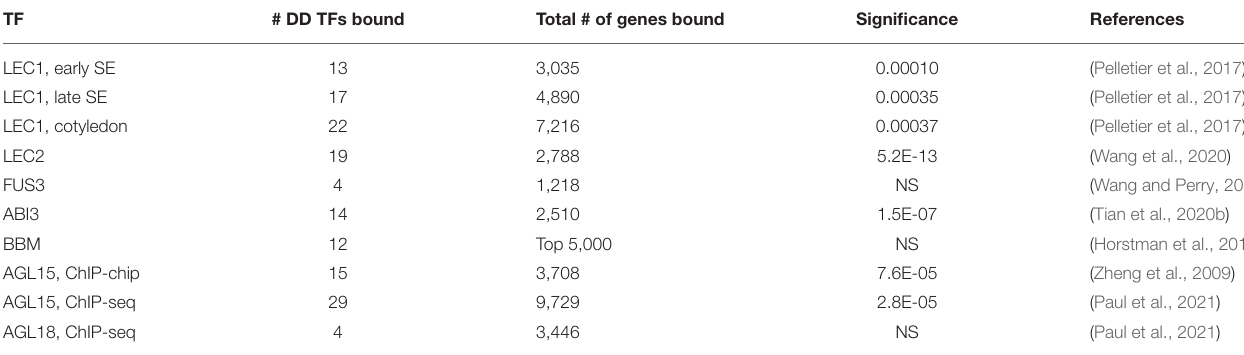
TABLE 1 | Overrepresentation of TFs associated with dedifferentiation (DD TFs) among the genes with regions bound by TFs involved in SE. TF # DD TFs